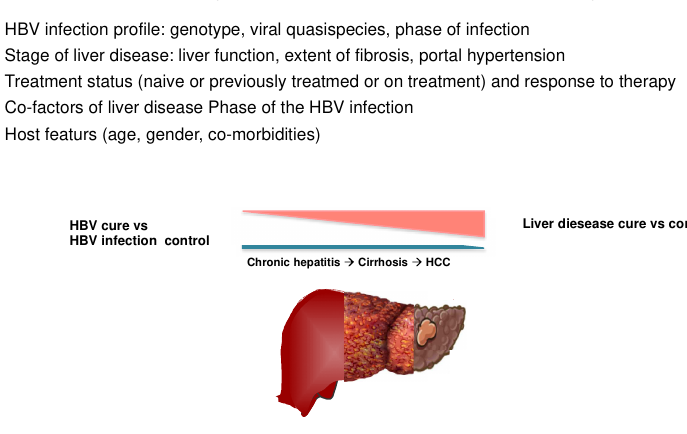
Figure 3. Virologic and clinical characteristics, that should guide the therapeutic choice in chronic hepatitis B patients to grant a personalized approach with both the currently available and the new drugs. The functional cure with a finite treatment should be pursued primarily in young patients with chronic hepatitis, whereas in older patients with cirrhosis the persistent inhibition of both viral replication and disease activity is a reasonable goal of antiviral therapy, as it was shown to stop/reduce the progression to end stage liver disease complications. An accurate characterization of the HBV infection profile and of its evolution overtime, together with the treatment history of the patient will further guide the selection for each patient of the most appropriate treatment strategy, particularly when new antiviral and immune modulatory drugs will be available.